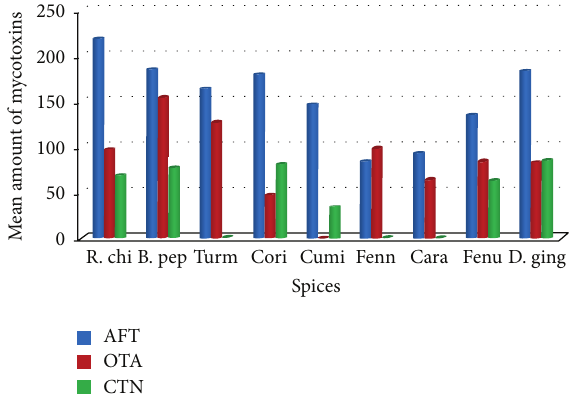
Figure 5: Amount of total aflatoxins, ochratoxin A, and citrinin in different